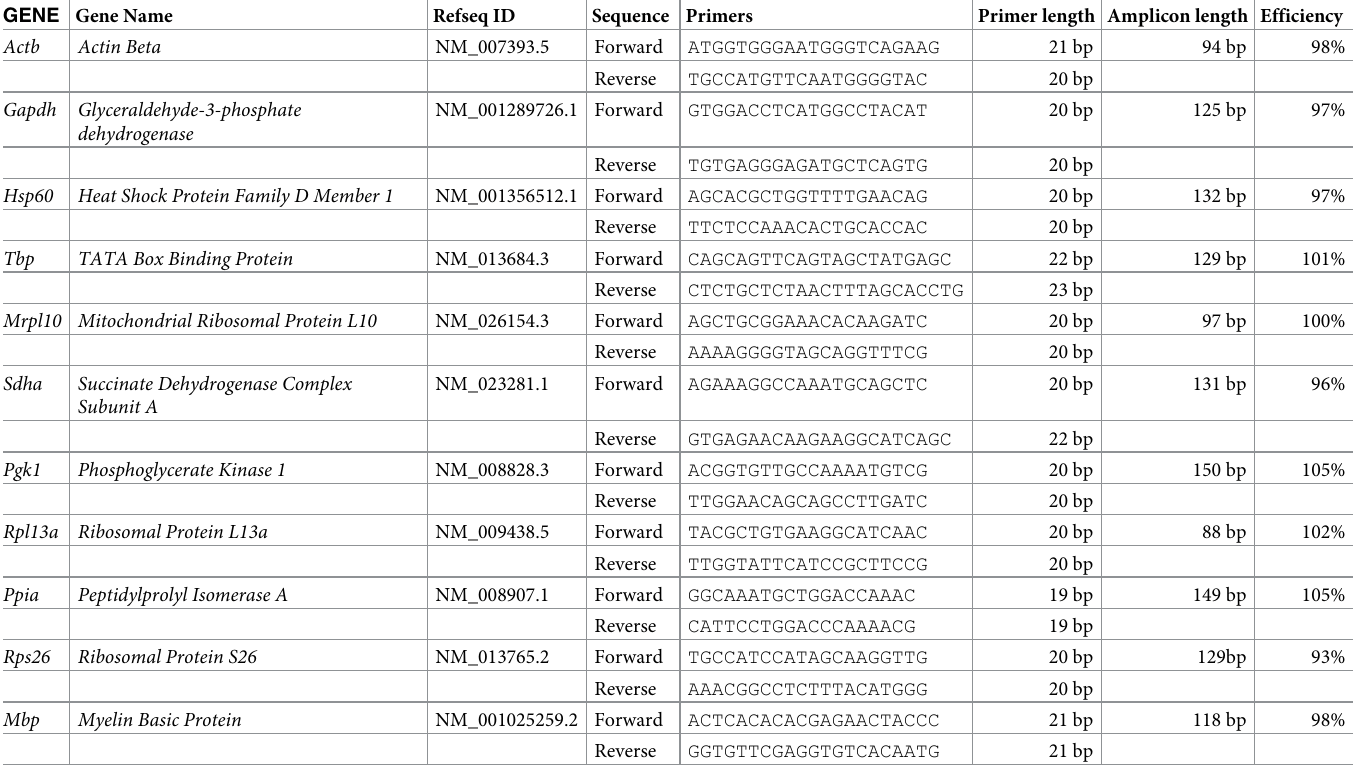
Table 3. Details of the primer sequences used in the